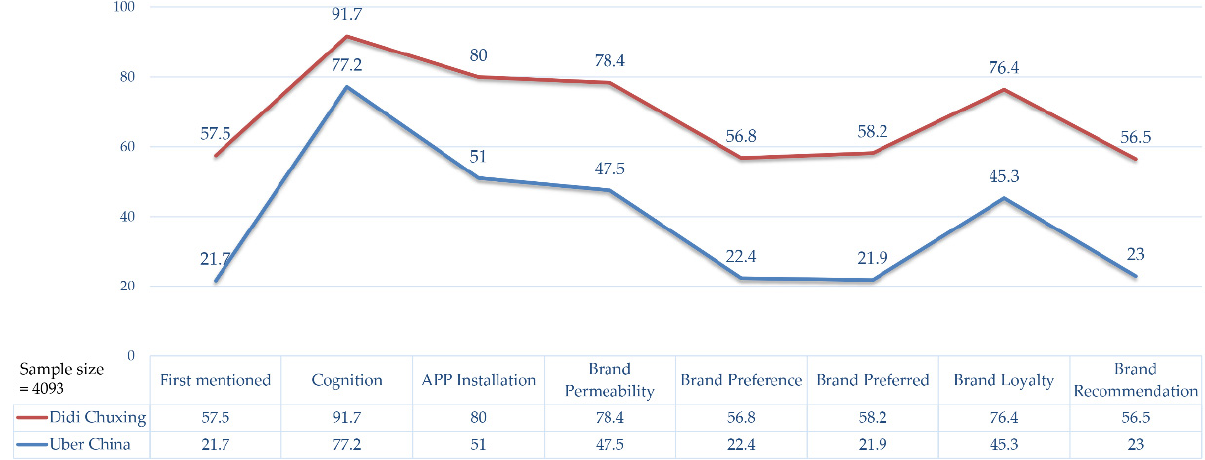
Figure 4. Comparison of brand influence between DiDi Chuxing and Uber China.